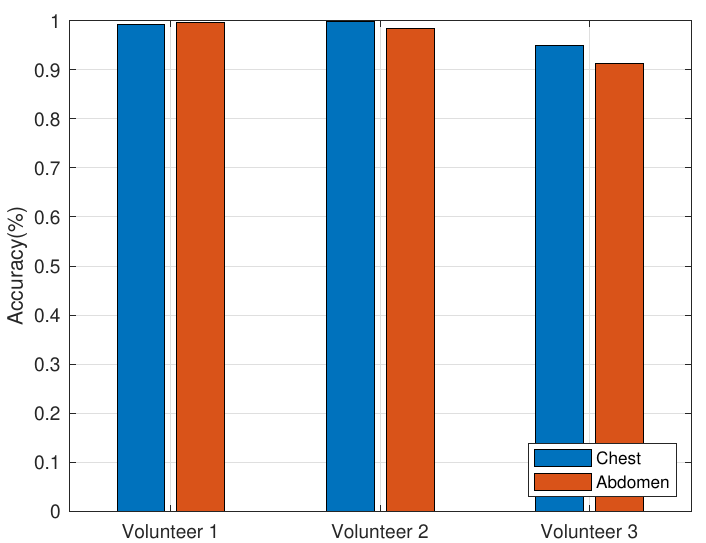
Figure 18. Results of multi-person respiratory monitoring statistics.